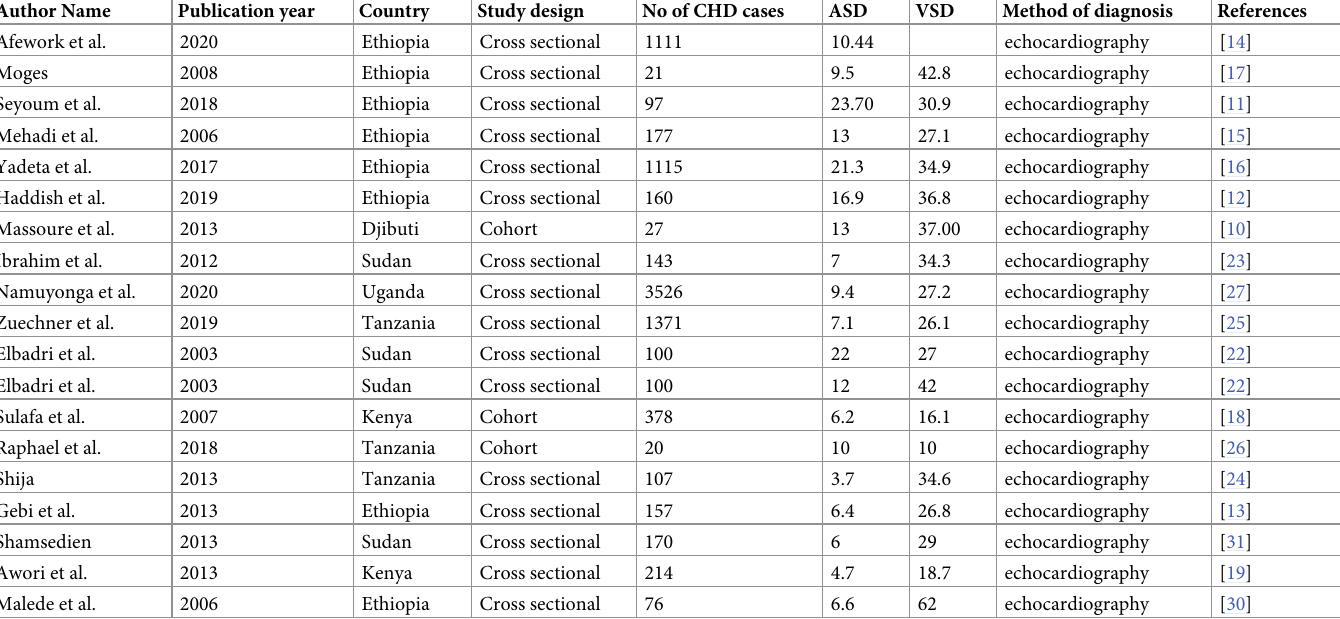
Table 1. Distribution of included studies on the magnitude of congenital septal defects among congenital heart defect patients in East Africa, from January 2000- October